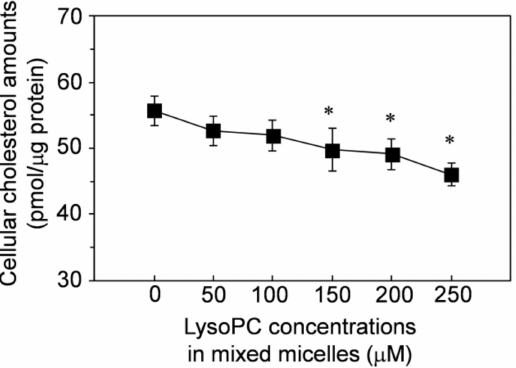
Figure 7. Reducing effect of lysophosphatidylcholine in mixed micelles on cellular cholesterol amounts in the differentiated Caco-2 cells. The differentiated Caco-2 cells were incubated for 2 h with the mixed micelles containing lysophosphatidylcholine at 0–250 µ M. The mixed micelles contained no vitamin D. Data are presented as the means ± standard deviation of four wells in a single experiment. Replicate experiments showed a similar trend. The asterisks indicate significant differences from the value of lysophosphatidylcholine at 0 µ M as determined by Dunnett’s test ( p < 0.05).